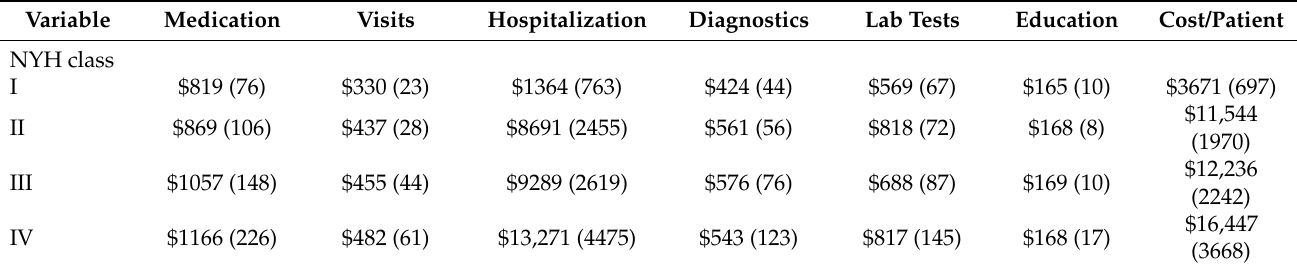
Table 2. The average annual direct medical costs by components per HF